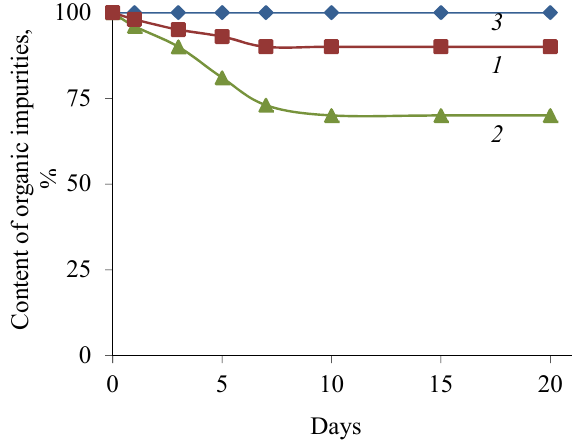
Fig. 4. Change in the content of trichlorethylene ( 1 ), dichloroethane ( 2 ) and chloroform ( 3 ) in water in the presence of sucrose over